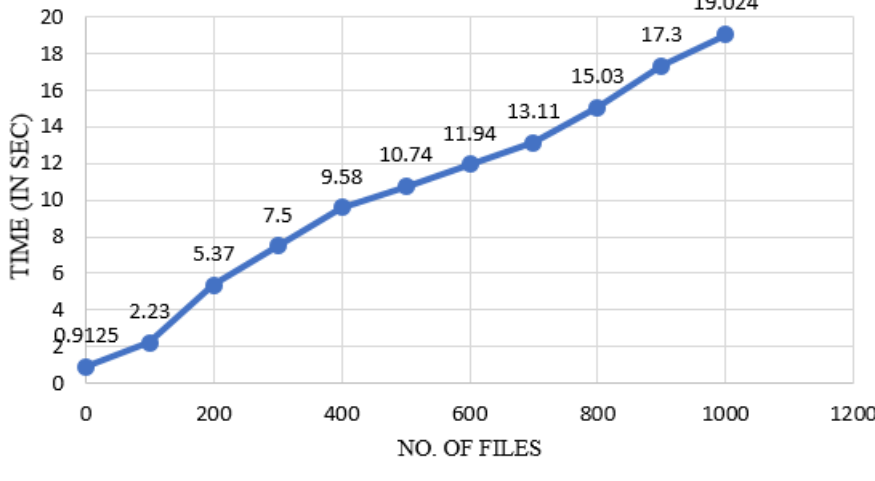
Figure 9. File Encryption Time